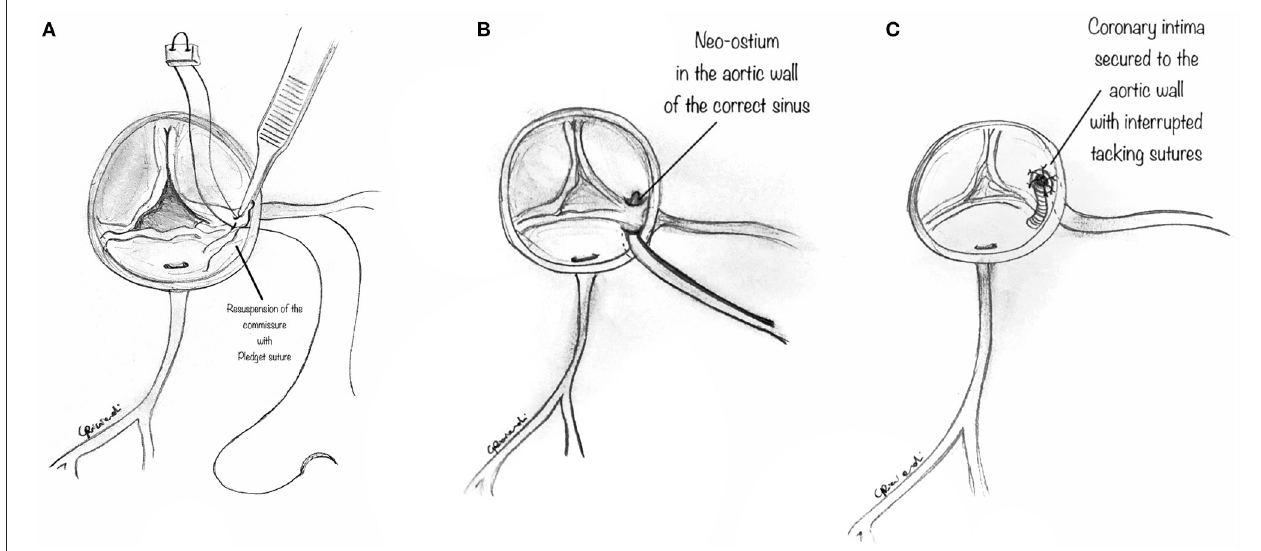
FIGURE 5 | (A) The diagram shows that the previously detached commissure is then resuspended with pledgeted sutures in order to create a neo-commissure, and preserve aortic valve integrity. (B) The diagram shows a surgical alternative when the intramural coronary segment is located below the commissure. In such a case, a “neo-ostium” can be created in the aortic wall of the correct sinus, opposite to the point where the coronary artery emerges from the aortic wall. (C) Interrupted tacking stitches are placed circumferentially around the ostium, securing the coronary intima to the aortic wall with the aim of preventing intimal dissection at the